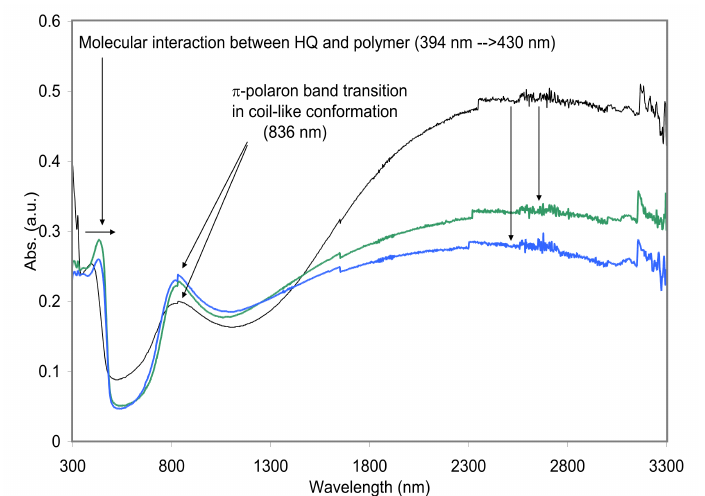
Figure 3. SEM image of PANI-DNNSA films that were: ( a ) air-dried (bar scale: 10 um) and ( b ) thermally treated (bar scale: 100 um).